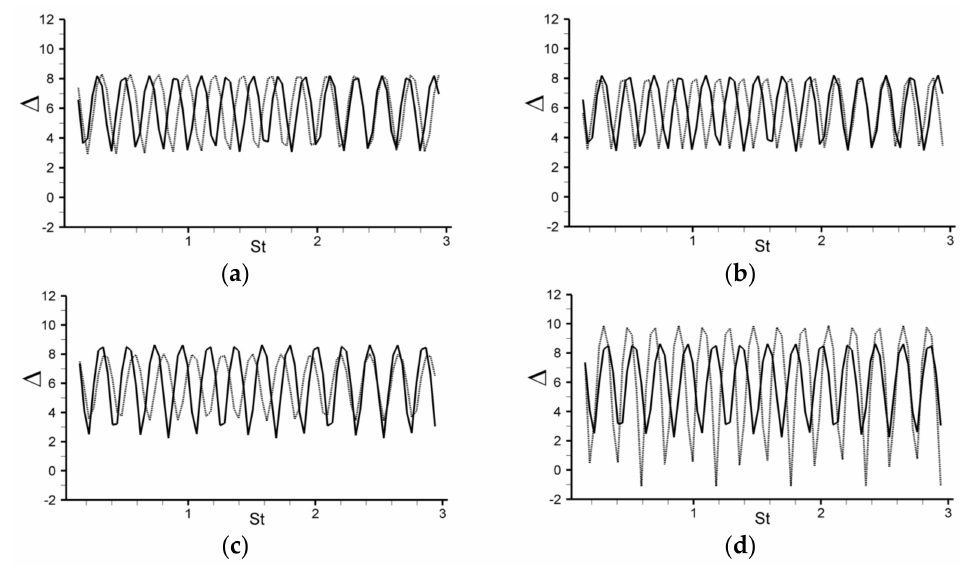
Figure 14. Low to high frequency ( St = [0.294; 2.94]) noise radiation from the trailing edge of an airfoil set at low ( α = 0 ◦ , solid line) or high ( α = 25 ◦ , dashed line) incidences. Deltas (in dB) between the incident and total RMS pressure fields, as recorded for two pairs of microphones: M1 ± ( x M / c = 0.5) and M2 ± ( x M / c = 2) on top and bottom walls: M1 + ( a ), M1 − ( c ), M2 + ( b ), M2 − ( d